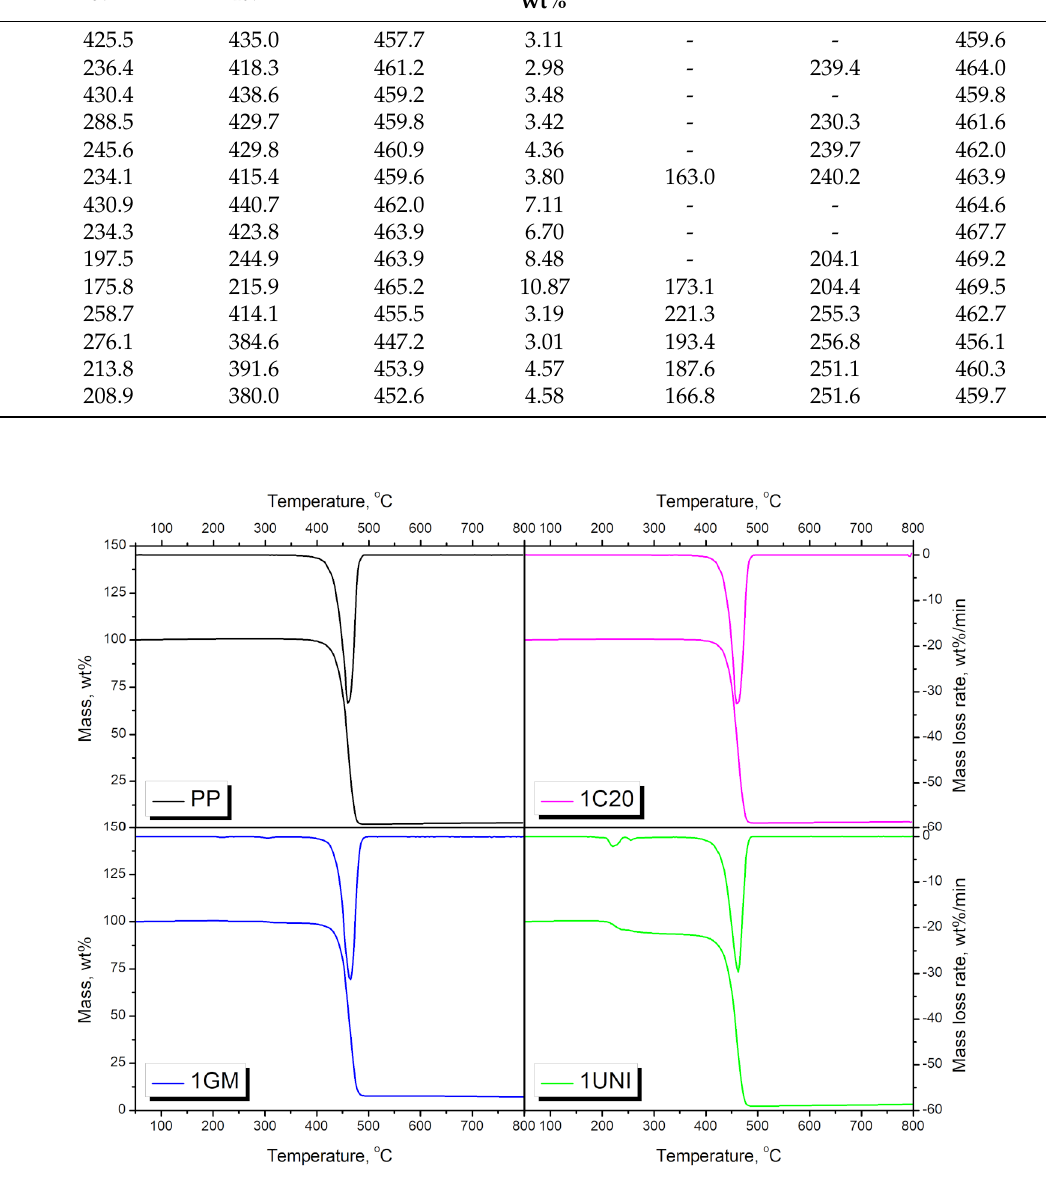
Figure 11. Results of TGA analysis for neat PP and PP modified with blowing agents.